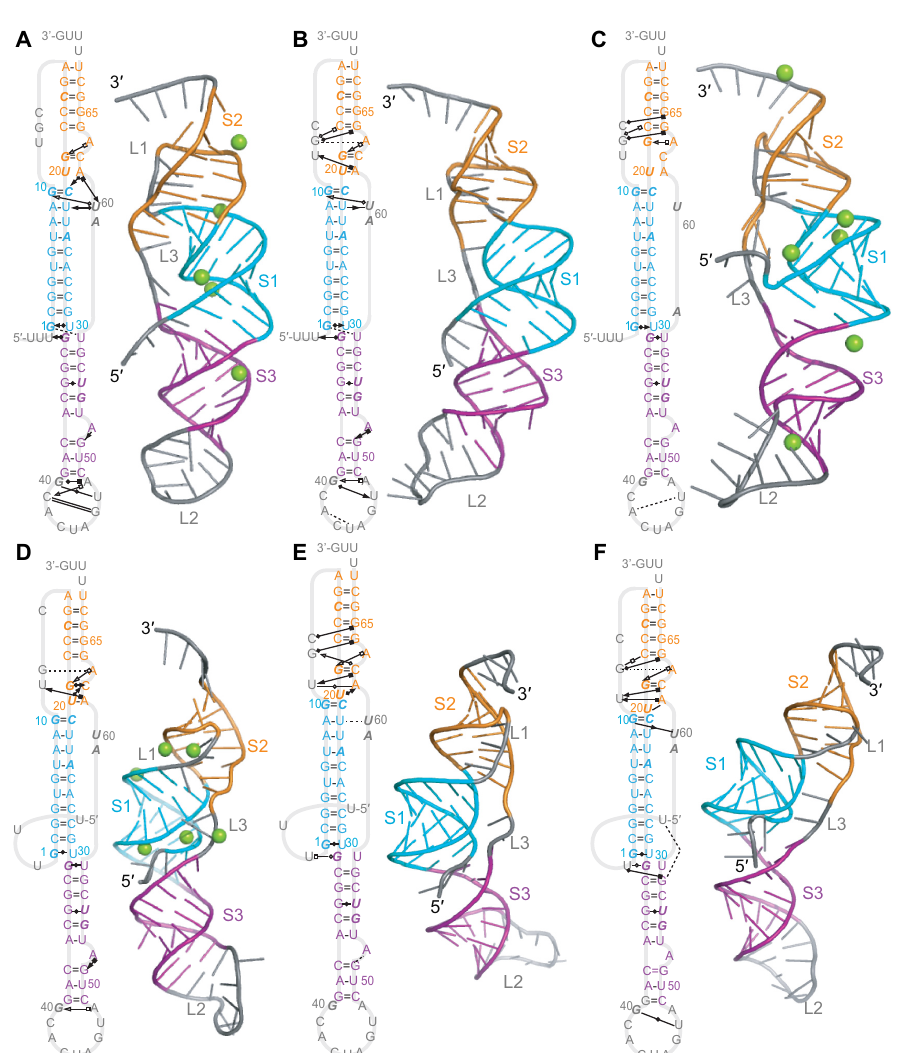
Fig 6. Representative structures from simulations with extended 3 0 ends. Secondary structures and representative 3D structures of the most populated clusters. (A) Unthreaded model from FARFAR2 with Mg 2+ . (B) Unthreaded model from FARFAR2 without Mg 2+ . (C) Unthreaded model from Vfold with Mg 2+ . (D) 5 0 -threaded model from FARFAR2 with Mg 2+ . (E) 5 0 -threaded model from SimRNA without Mg 2+ . (F) 5 0 -threaded model from FARFAR2 without Mg 2+